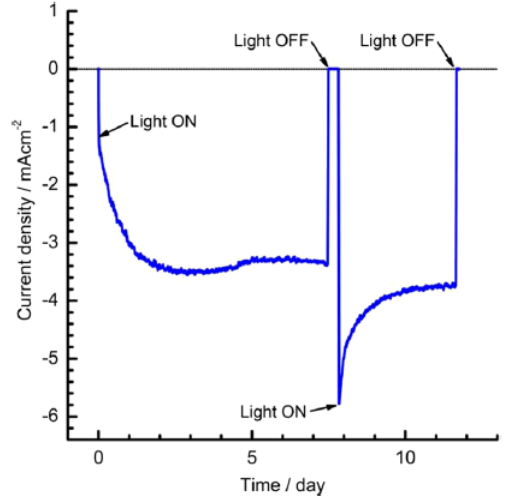
Figure 1. Current-potential curves for Pt/CuGaSe 2 and Pt/CdS/CuGaSe 2 electrodes [0.1 M Na 2 SO 4 (aq), pH 9, 300 W Xe lamp]. Reprinted with permission from Reference [42] (Copyright American Chemical Society 2013).